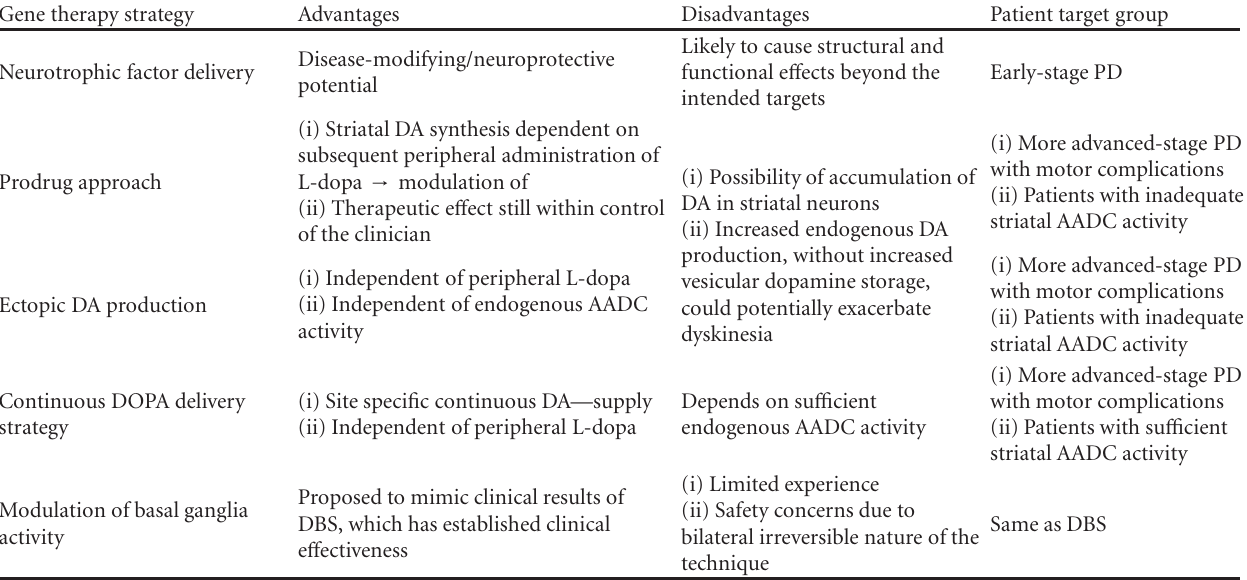
Table 2: Patient-centred comparison of gene therapy interventions for